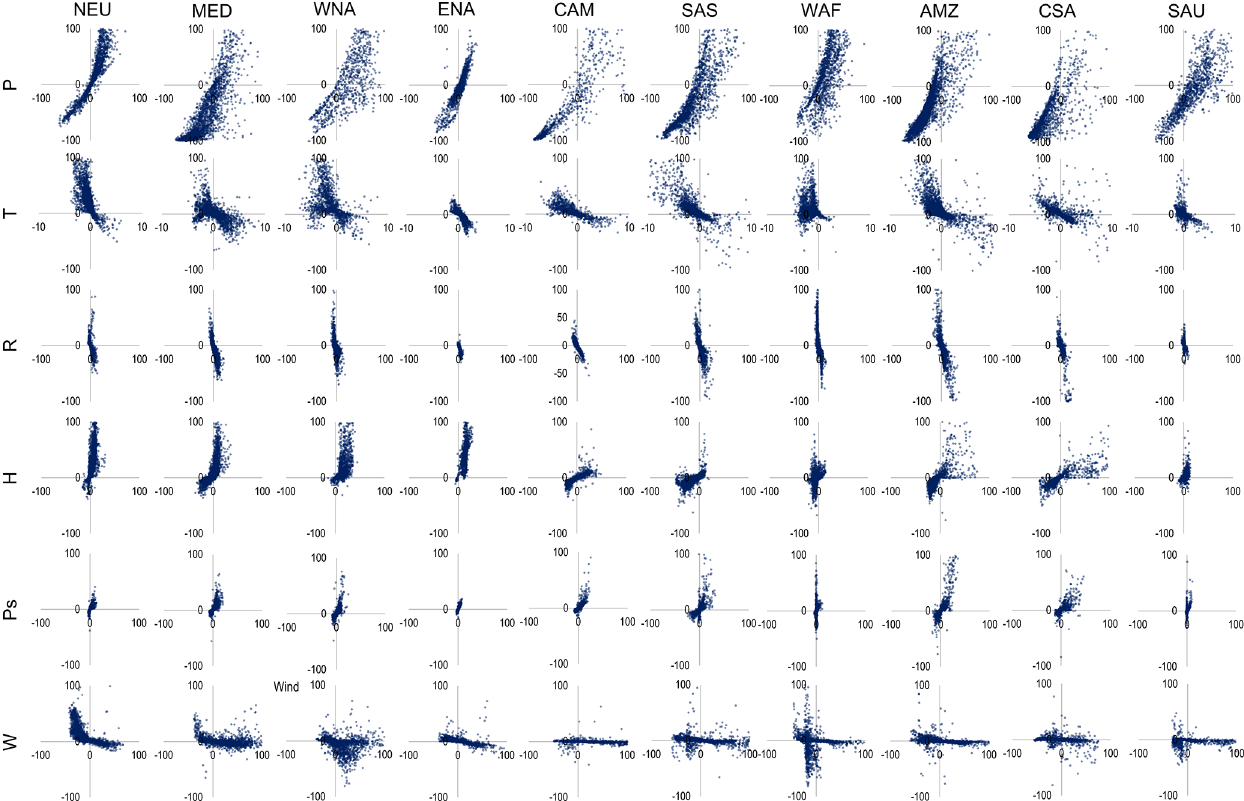
Figure 9. Scatterplots of relative changes in the forcing variable ( (cid:49)V , x axis) and corresponding relative changes in runoff ( (cid:49) RF, y axis), for all the forcing variables and for selected regions. In each panel, each dot represents the (cid:49) RF /(cid:49)V relationship of each land grid box in the examined